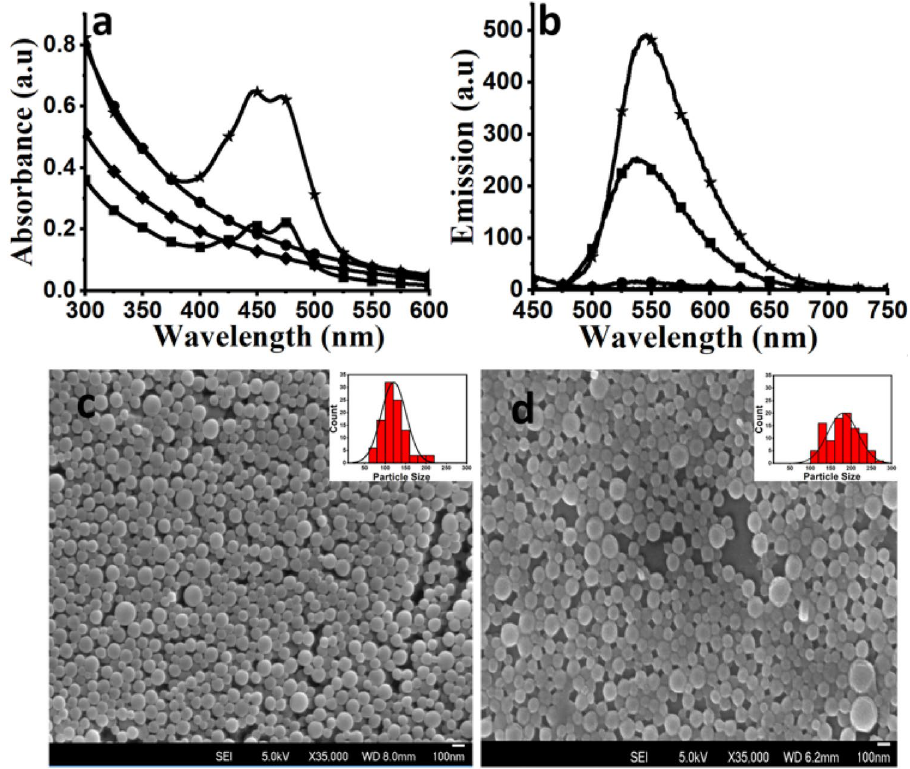
Figure 1. Absorption ( a ) and emission ( b ) spectra of polymer NPs, PVC (*), PMMA ( ■ ), and pure polymers, PVC ( ) and PMMA ( ♦ ) solutions. The NPs are dispersed in water and spectra for pure polymer for comparison was recorded in tetrahydrofuran . SEM images of PMMA (c) PVC (d) NPs, insets represent the size ● distribution curve of polymer NPs obtained from SEM image. Scale bar − 100 nm.